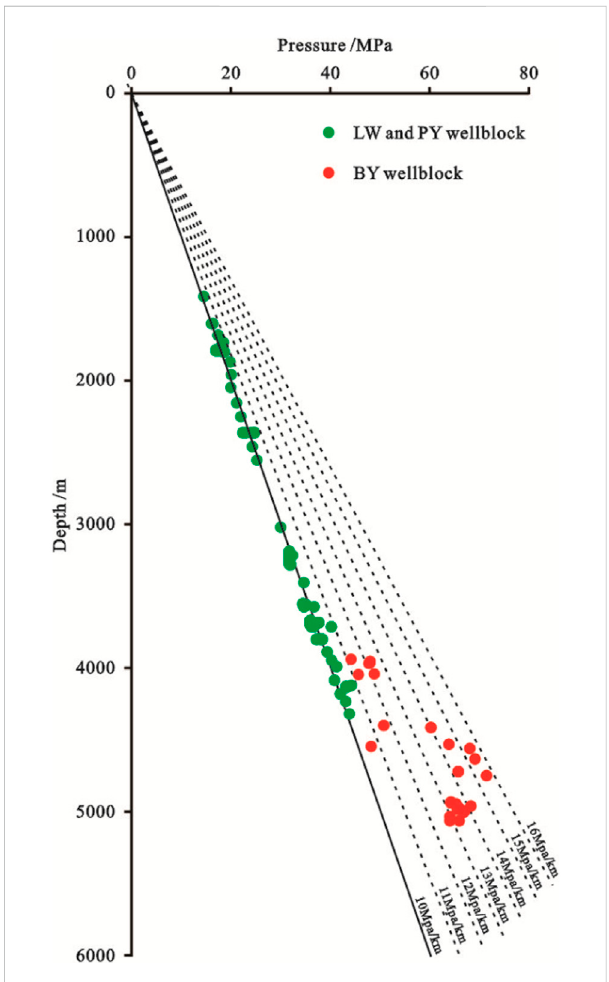
FIGURE 3 Pore pressure coef fi cient pro fi le of the study